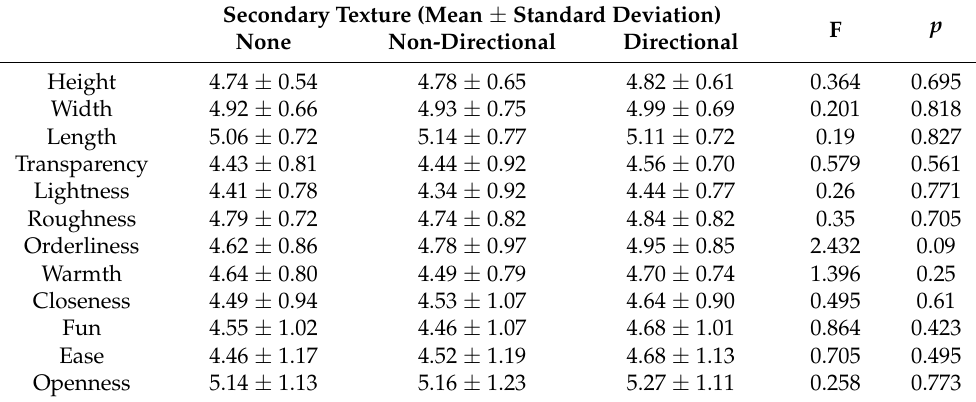
Table 15. Variance analysis of secondary texture